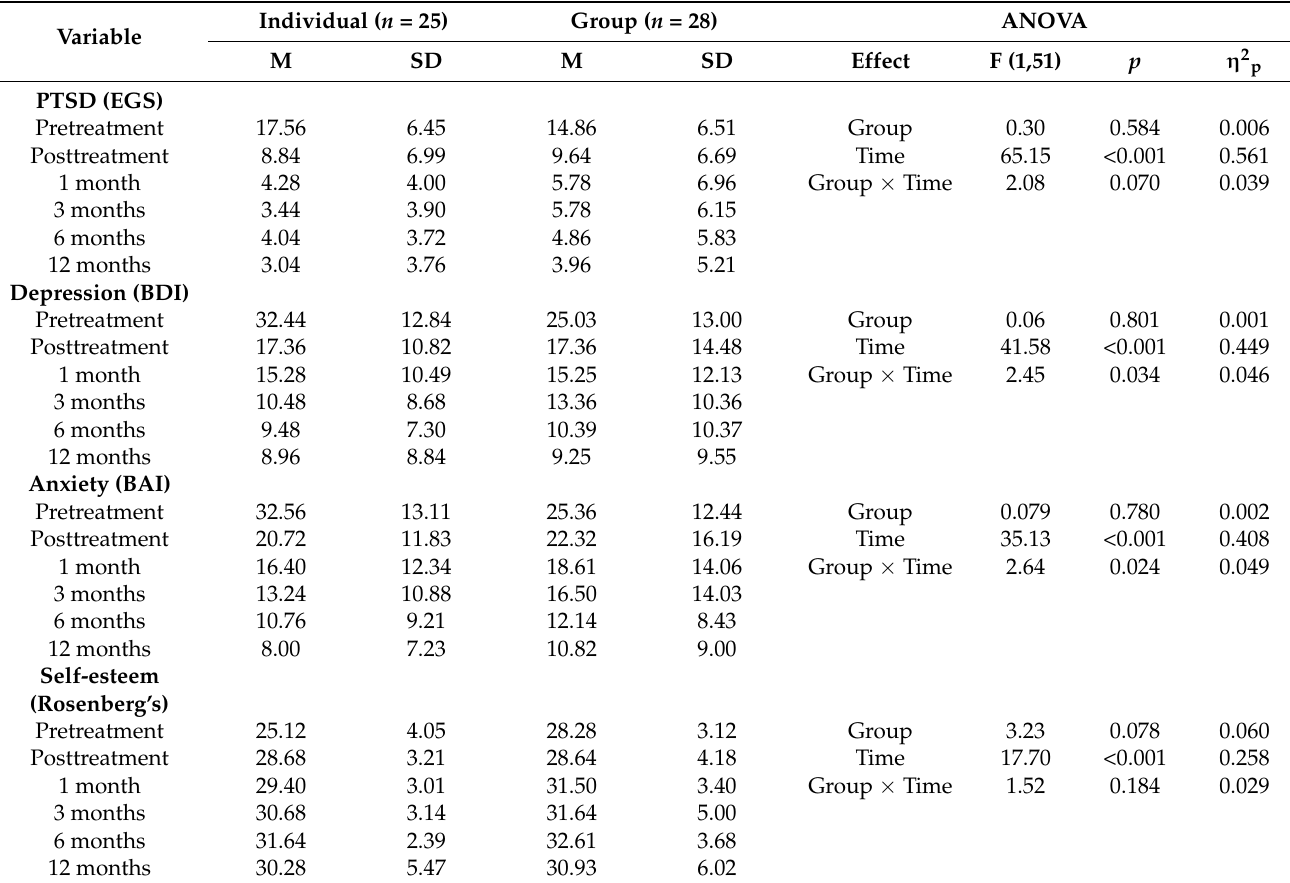
Table 2. Means, standard deviations and repeated measures ANOVA statistics for clinical variables ( n =